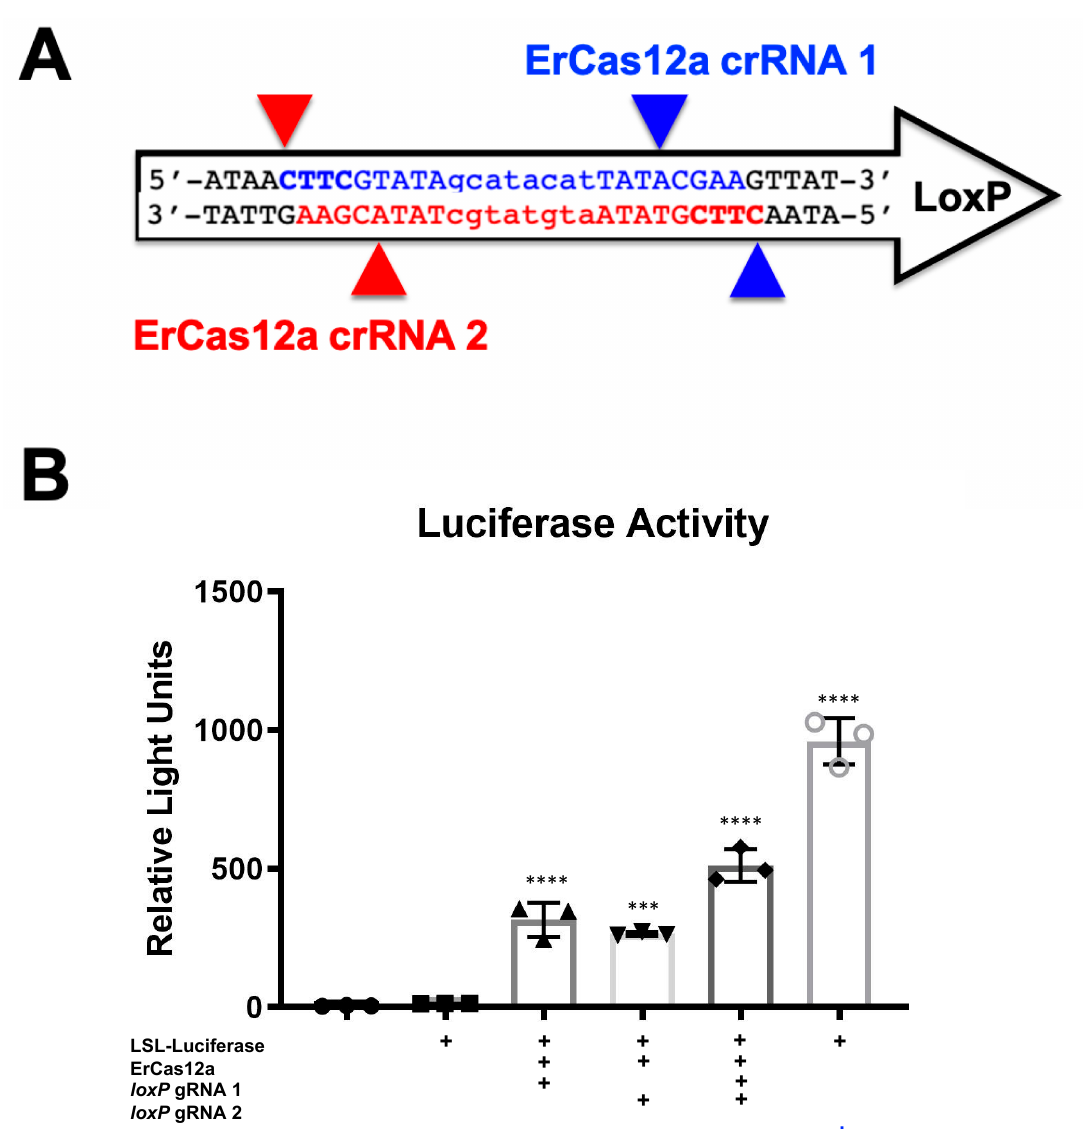
Figure 2. ErCas12a-mediated gene activation through targeting lox P in vitro. ( A ) The lox P sequence is shown with key features and target sites for CRISPR ErCas12a. The capitalized base pairs are the 13-base-pair palindromic regions flanking the 8-base-pair core that gives lox P its directionality. gRNA 1 homologous strand to the guide RNA is depicted in light blue with the PAM-binding region in dark blue and bold letters and a triangle to indicate the cleavage site. gRNA 2 depicts the same in red. ( B ) The ErCas12a plasmid co-expressed either gRNA 1 or 2 and was co-transfected with the LSL-Luc reporter plasmid at 2.5 ug. By one-way ANOVA with Tukey’s multiple comparisons, all the groups were significant except between the untransfected control groups (untransfected versus reporter plasmid only) and between the individual gRNA-treated groups ( lox P gRNA 1 vs. lox P gRNA 2); 95% confidence intervals are shown (n = 3) (*** p < 0.0005 and **** p < 0.0001).